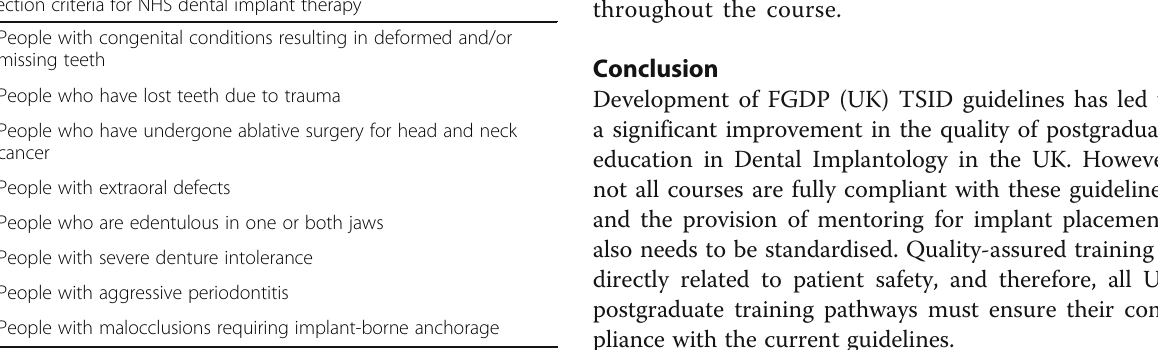
Table 5 Selection criteria for NHS dental implant therapy Selection criteria for NHS dental implant